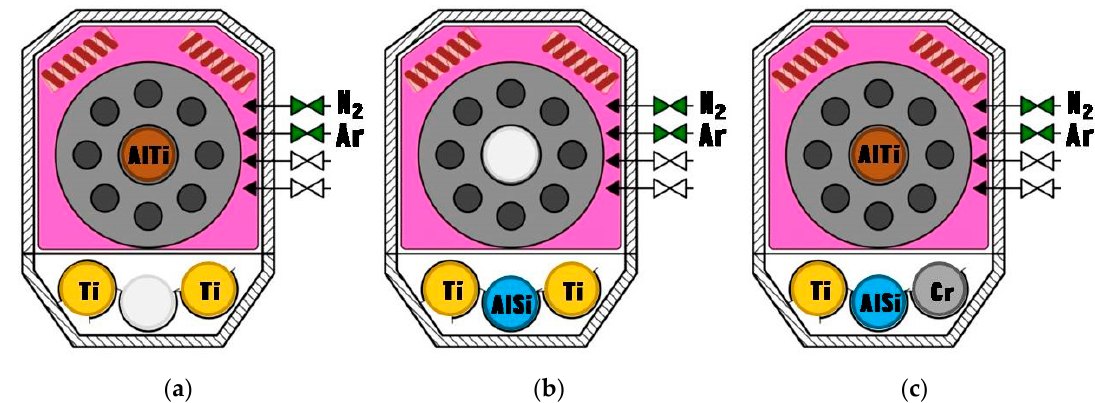
Figure 4. The configuration of the cathodes located in the vacuum chamber of the technological unit during the application of various multi ‐ component coatings on carbide end mills: ( a ) TiN–Al/TiN; ( b ) TiN–AlTiN/SiN; ( c ) CrTiN–AlTiN–AlTiCrN/SiN. ( b ) TiN–AlTiN / SiN; ( c ) CrTiN–AlTiN–AlTiCrN /